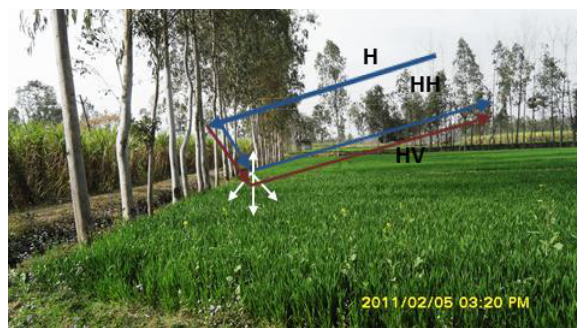
Figure 1 An image of typical cropland (Wheat crop) bunded by tall trees. Arrows on image shows the interaction of SAR polarized signals with tree trunk and Wheat crop in rotated Dihedral